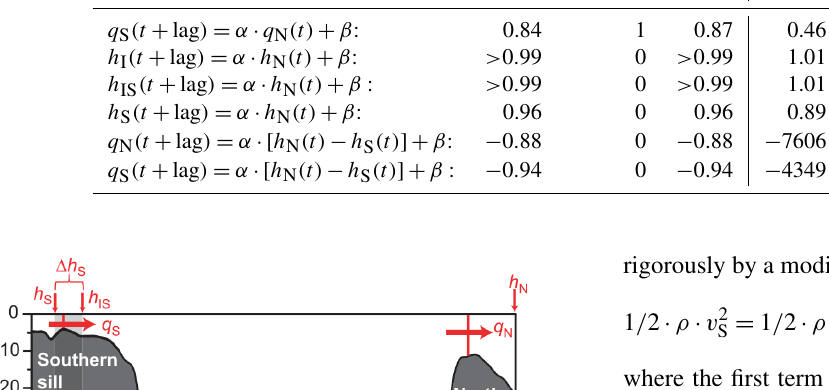
Table 2. Lagged correlation and regression analysis of relationships between hourly values of various simulated time series where t represents time. R 0 is the correlation coefficient for zero lag. Lag max is the lag (in hours) that gives the numerically highest correlation coefficient. R max , α max , and β max are the correlation coefficient and the regression coefficients for that lag. Regression equation R 0